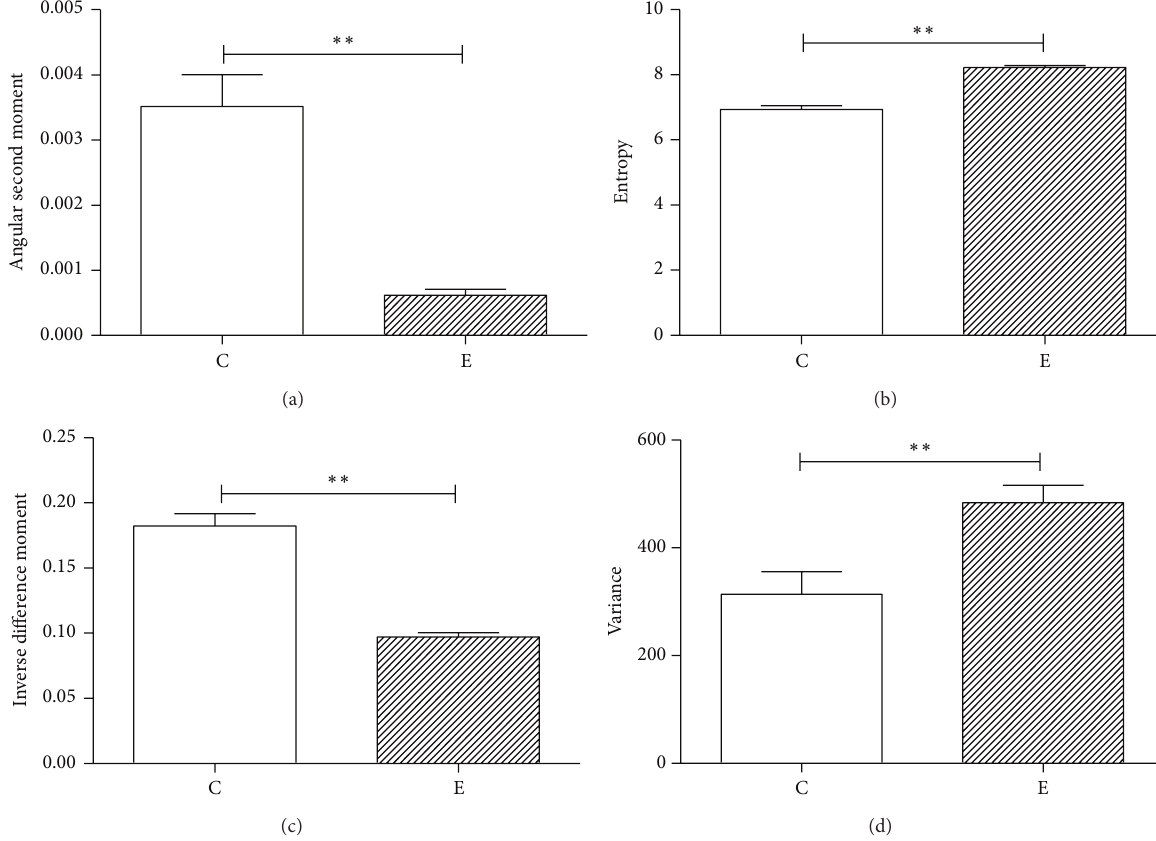
Figure 5: 𝑡 -test analysis of four texture features of plant microtubules between different images. (a) 𝑡 -test analysis of angular second moment; (b) 𝑡 -test analysis of entropy; (c) 𝑡 -test analysis of inverse difference moment; (d) 𝑡 -test analysis of variance. C: control group; E: experimental group. ∗∗ 𝑃 < 0.01